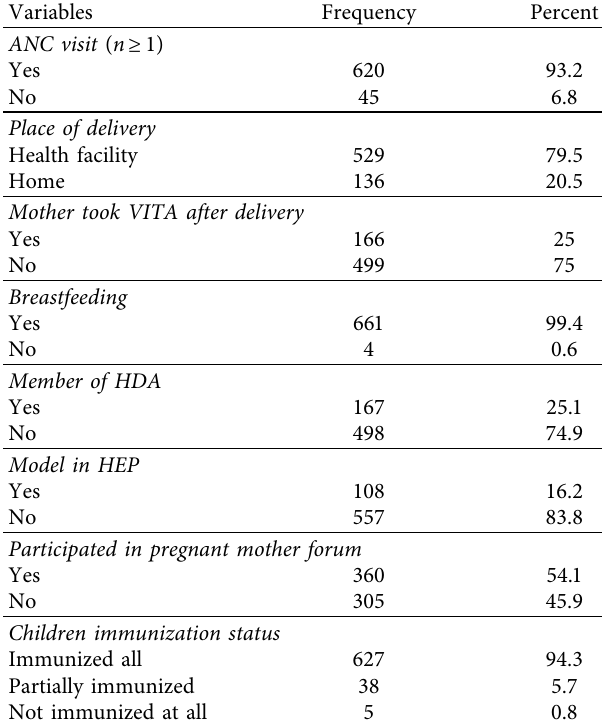
Table 4: Health seeking behavior of mothers with children